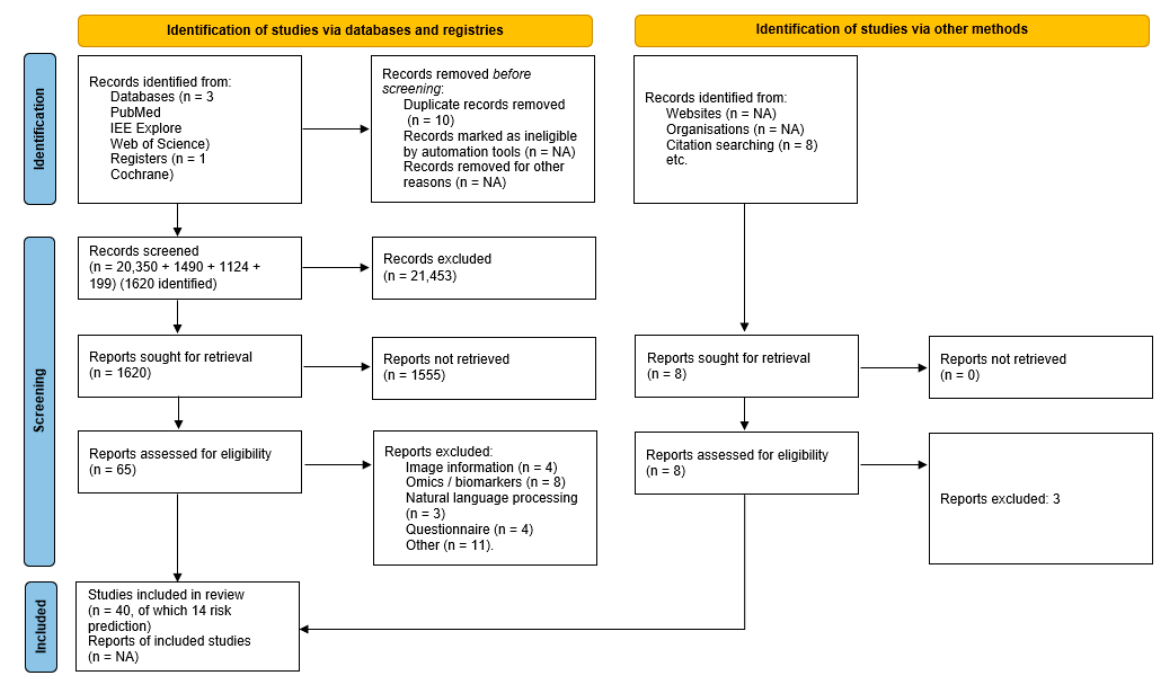
Figure 1. PRISMA flow diagram for systematic review. NA – not applicable.